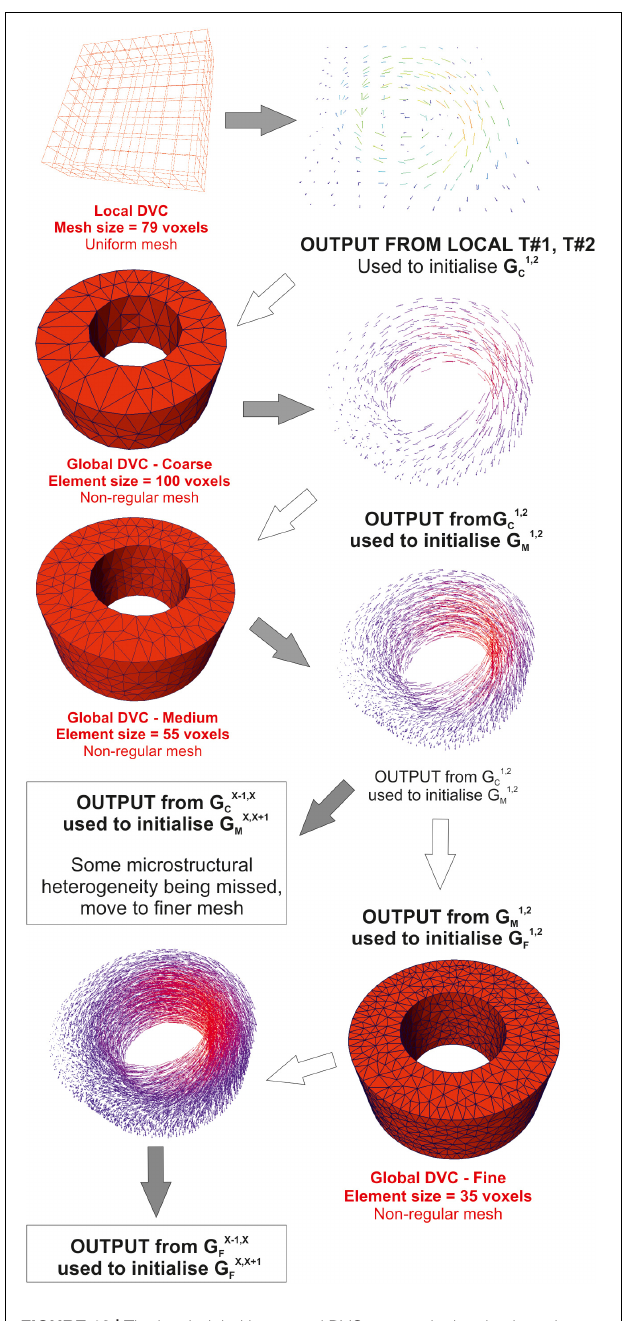
FIGURE 10 | The local-global integrated DVC approach showing how the outputs from one iteration and scale can be used to initiate the calculation at the next spatial or temporal step. G, global; C, coarse; M, medium; F, fine. The size of the regular and irregular meshes should be adjusted to the sample structure and material texture under consideration. The meshes shown were those applied to the experiment discussed in section “Bubble Bearing Magma (High Temperature)” and shown in Figures 6 , 7